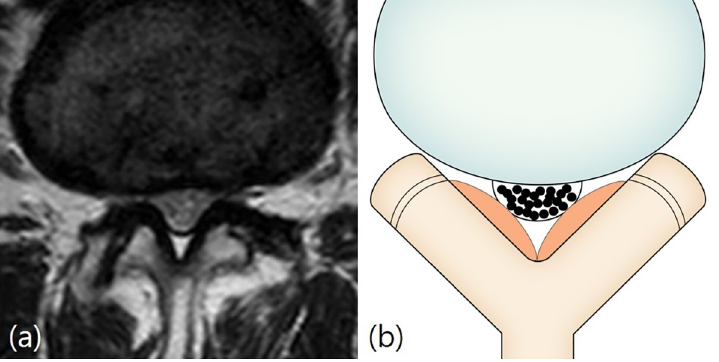
Fig 5. Lee classification. Grade 2 (moderate stenosis). Fig 5A and 5B: A 59-year-old woman with right lower extremity radiculopathy. T2-weighted axial magnetic resonance image at L4/5 disc level shows moderate obliteration of the anterior cerebrospinal fluid space and some cauda equina